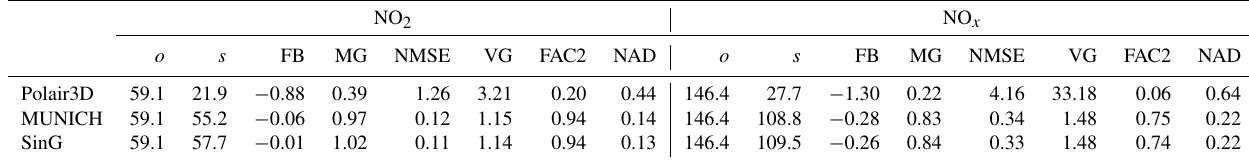
Table 4. Statistical parameters ∗ at traffic stations ( o and s represent the average observed and simulated concentrations, respectively; µgm − 3 ). NO 2 NO x